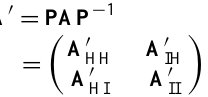
Table 2. Experimental and temperature uncertainty sources used for our error estimation. The third column gives the uncertainty value and the fourth column the partitioning between statistical and systematic sources.